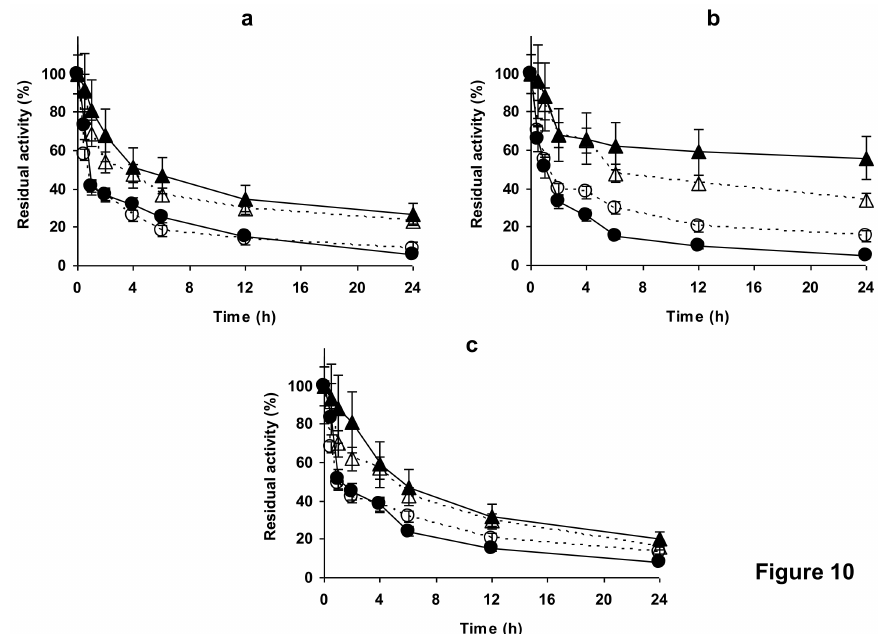
Figure 10. Inactivation of ficin immobilized at pH 7 using 25 mM sodium phosphate. Experiments were performed as described in Section 3, at pH 5 ( a ), 7 ( b ) or 9 ( c ) and 55 ◦ C. Solid lines and solid circles: inactivation was followed using BANA, Dotted line and empty symbols: inactivation was followed with casein. Circles: free enzyme; Triangles: immobilized enzyme.